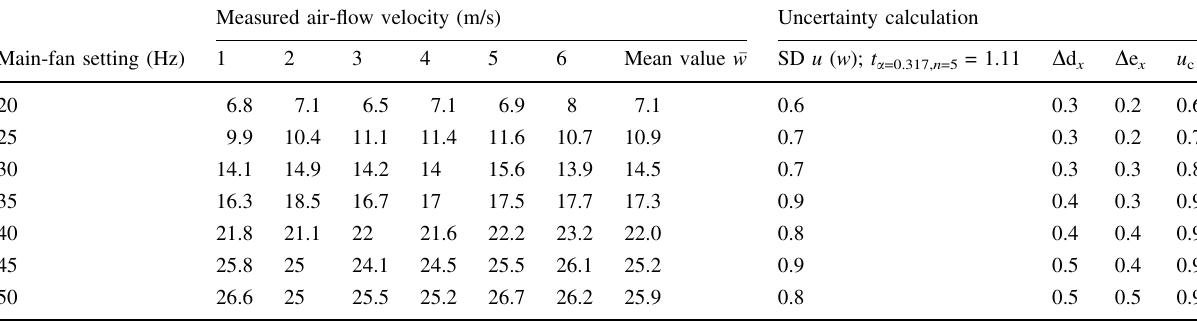
Table 12 Measured air-flow velocity in the suction zone, for assessment of the measurement uncertainty Measured air-flow velocity (m/s)